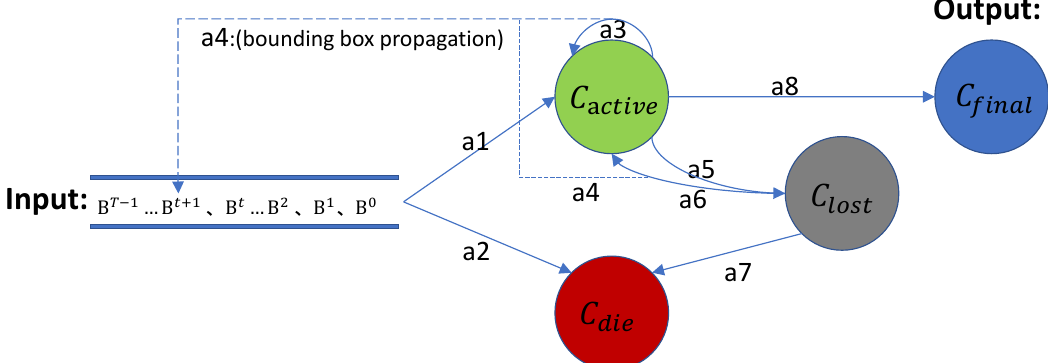
Figure 5. State transition diagram of our matching algorithm, where the input are bounding boxes belong to each frames { B } . C 0 , B 1 , B 2 ,..., B T − 1 active is a pooling storing tracklets that have been tracked so far. C lost is a pooling storing tracklets that tracked but lost. C die is a pooling storing tracklets judged to be illegal. C final is a pooling storing legal output tracklets. The transfer actions { a1, a2, ..., a8 } between them will be explained in detail below, and there will be corresponding annotations in the Algorithm